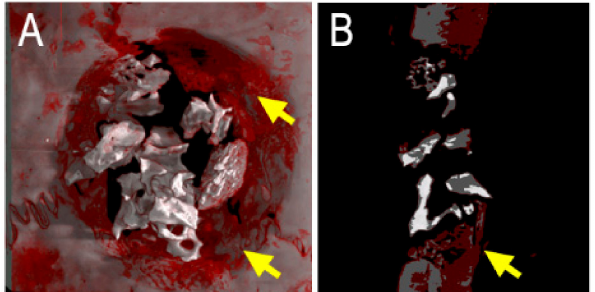
Figure 5. Micro-CT images of repaired sites in representative retrieved sample, evaluated at 30 days postoperatively. The borders of the defect have not been covered with bovine bone graft, thus being directly exposed to laser radiation. A great amount of newly-formed bone can be observed at the periphery of the defect, as indicated with yellow arrows. ( A ): 3D reconstruction; ( B ): transversal section. Grey tissue is mature bone; red tissue is bone under remodeling; white tissue is xenograft